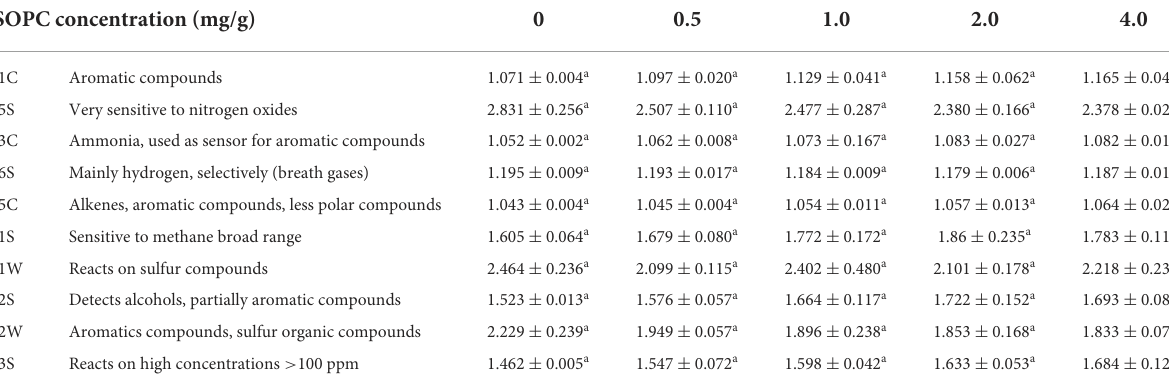
TABLE 2 Volatile flavor substance Loadings sensor contribution analysis with different concentrations (0, 0.1, 0.25, and 0.5 mg/mL) of LSOPC. LSOPC concentration